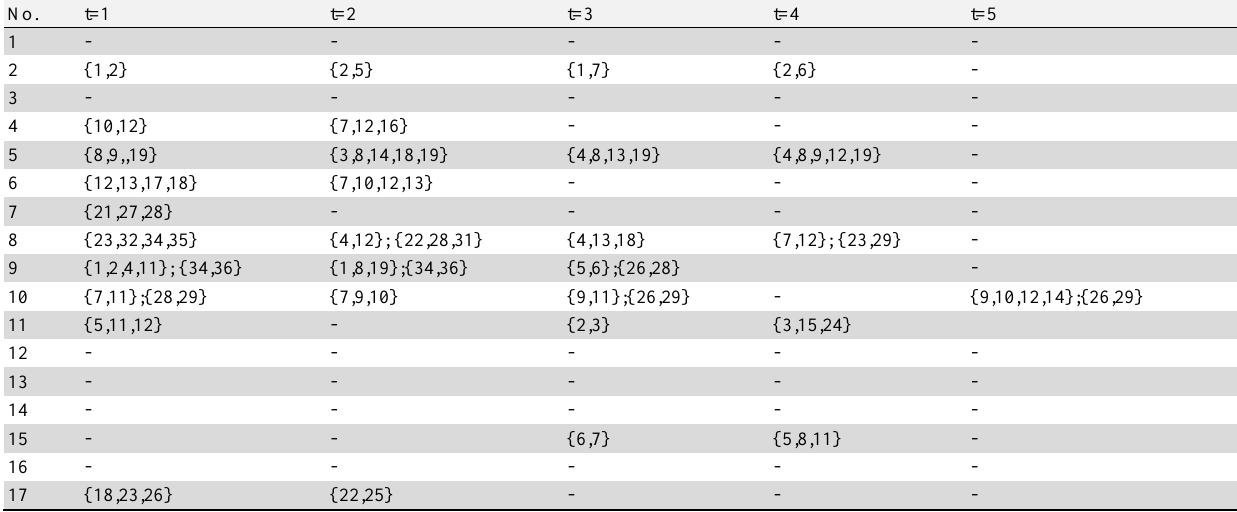
Observed dummy sub cells in the solved experiments